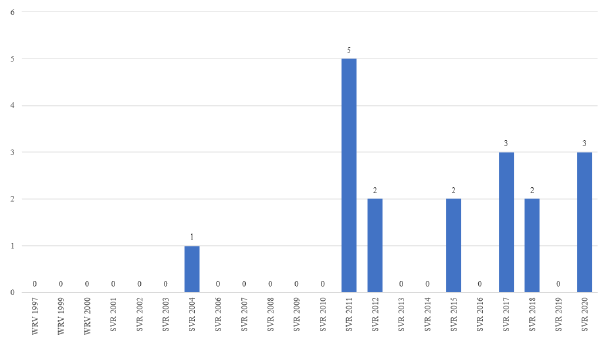
Figure 15. Overall distribution of papers from the “Immersive gam- ing/serious games”